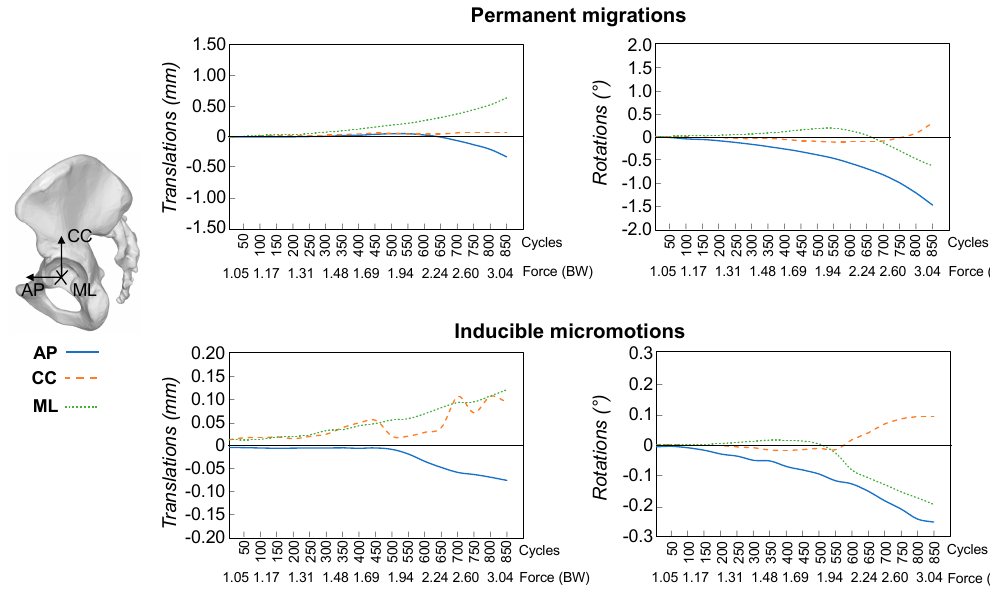
Figure 4. Morselized bone graft : The permanent migrations and inducible micromotions throughout the test are presented as the median trend of the specimens ( n = 5 hemipelvises). For the translations, the components along the antero-posterior (AP), cranio-caudal (CC) and medio-lateral (ML) directions are reported. The rotations are reported in terms of individual components about the antero-posterior (AP), cranio-caudal (CC) and medio-lateral (ML) axis. On the x -axis the load cycles (in packages of 50 cycles) and the corresponding magnitude of the applied force are indicated. Motions during the preconditioning load package are not presented.